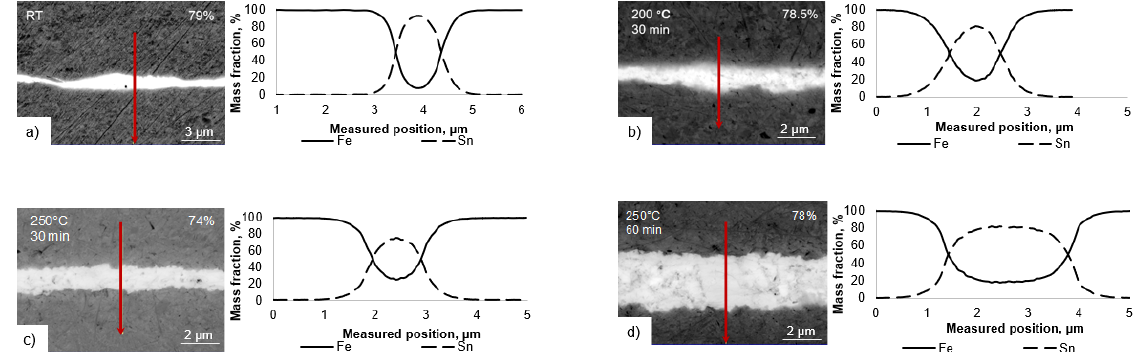
Figure 4. SEM images and corresponding line scans, along with the bonded interface in the initial state ( a ) as well as after the heat treatments at 200 °C for 30 min ( b ), at 250 °C for 30 min ( c ), and 60 min ( d ).